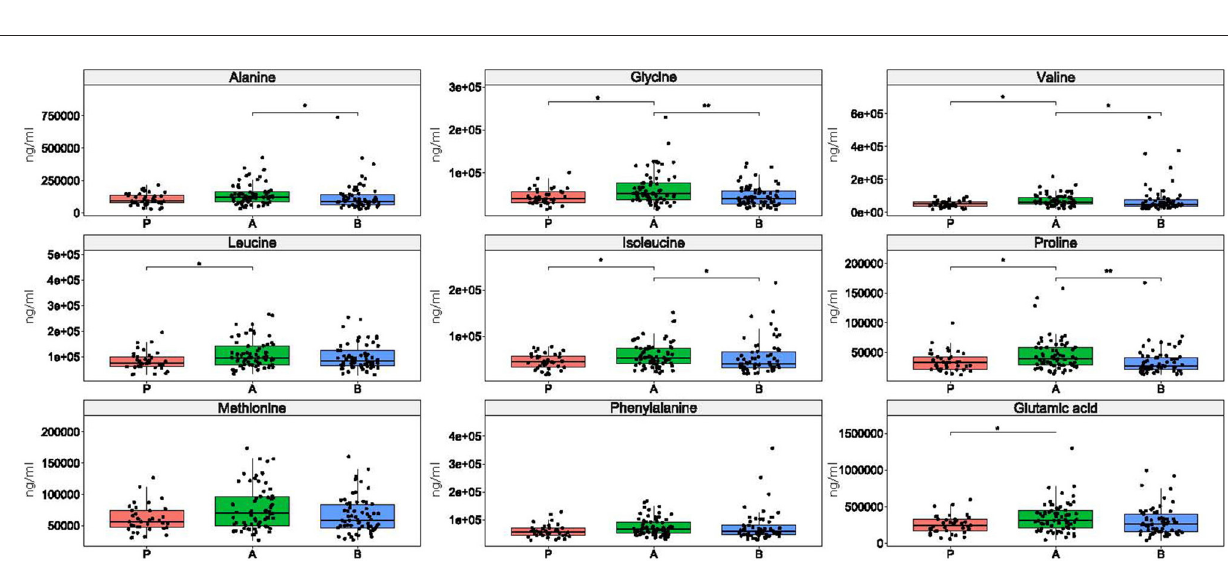
with the two other groups. Akkermansia is associated with overall good health and is less abundant among obese individuals